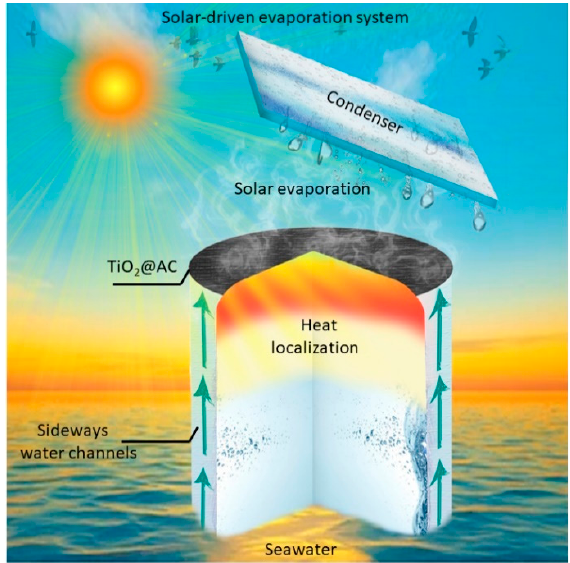
Figure 1. Schematic illustration of TiO 2 /AC-based solar evaporator, which endows efficient evaporation rates for effective desalination along with thermal management and self-floatability.